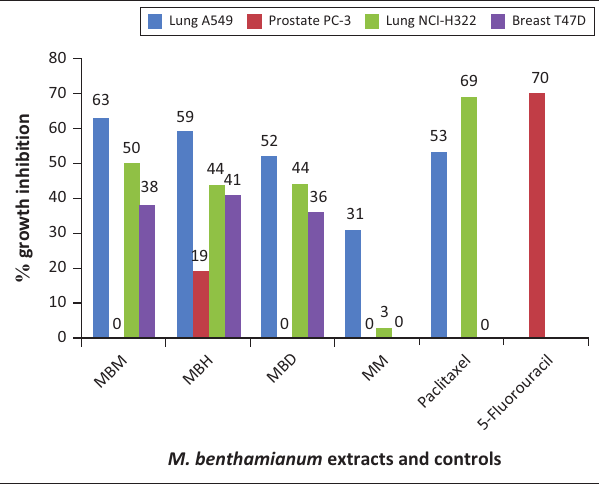
FIGURE 1: Percentage growth inhibition of the Mezoneuron benthamianum extracts against cancer cell